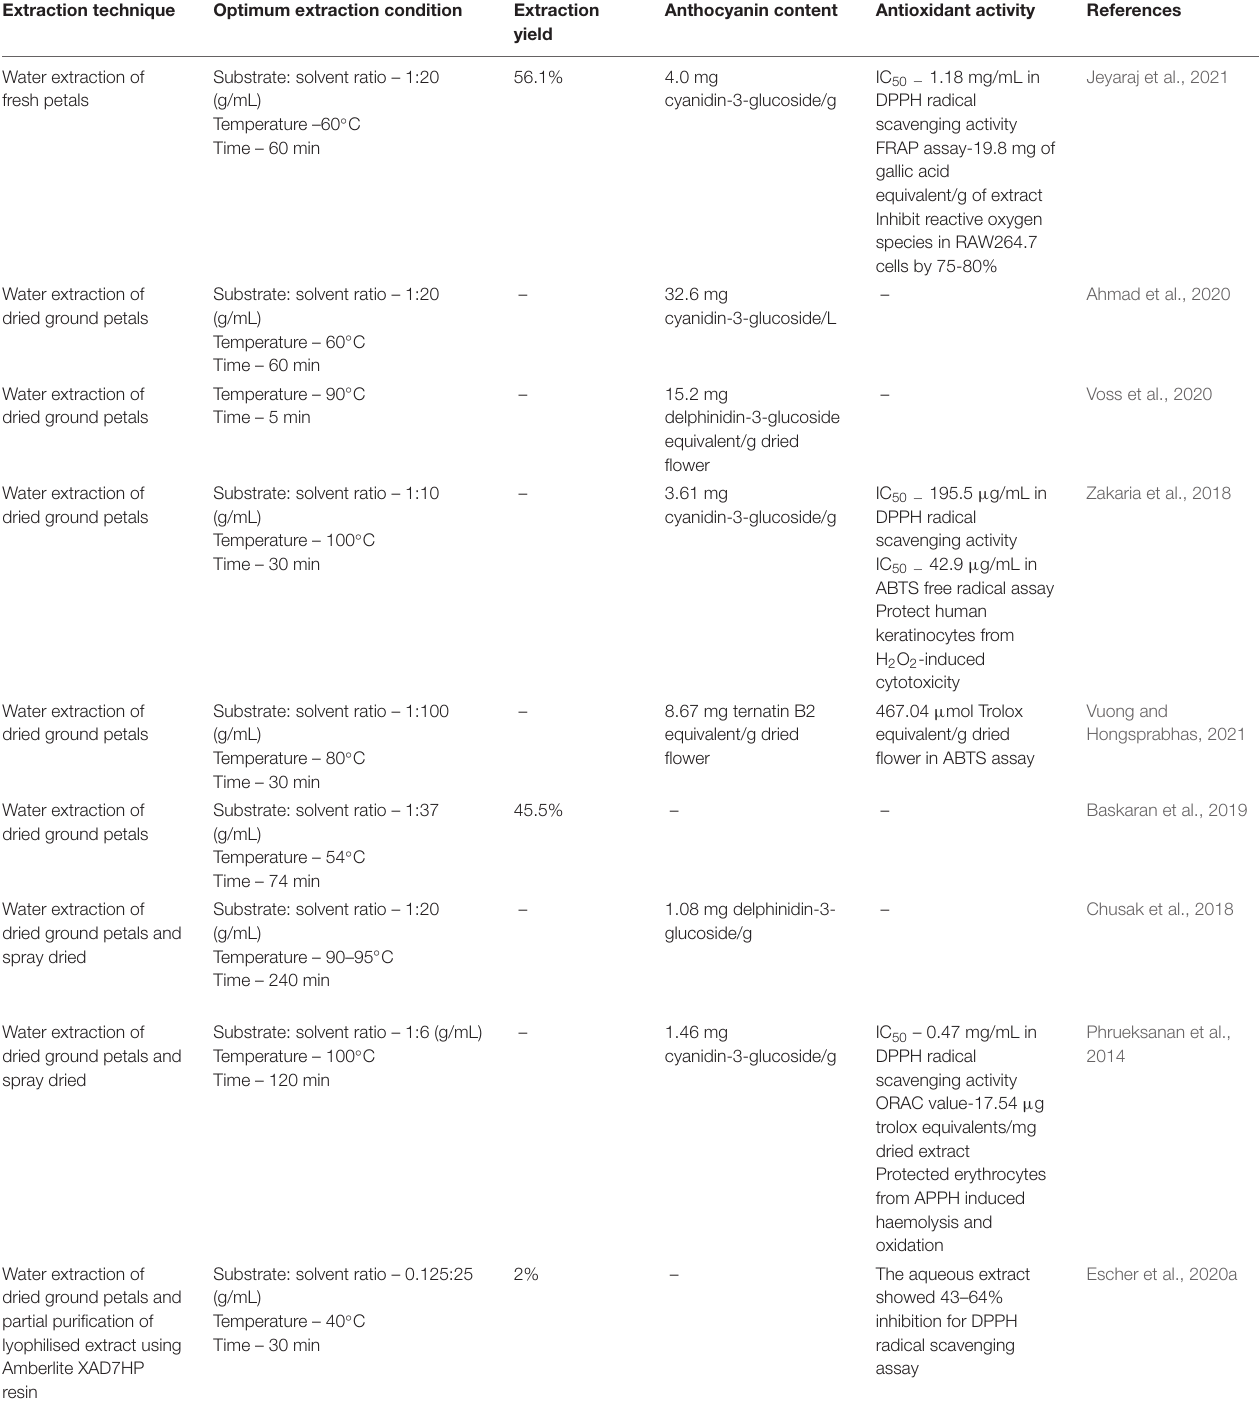
TABLE 1 | Previous studies on extraction of anthocyanins from blue pea flower using water and the antioxidant activity of extracts. Extraction